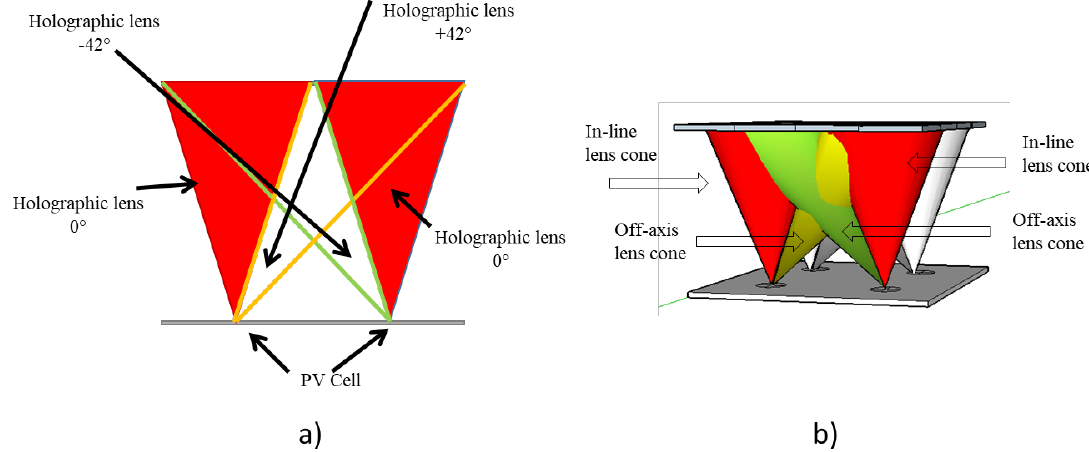
Figure 14. Angular multiplex lenses obtained by overwriting the same photopolymer region with different angles: ( a ) bi- dimensional view, ( b ) three-dimensional view.